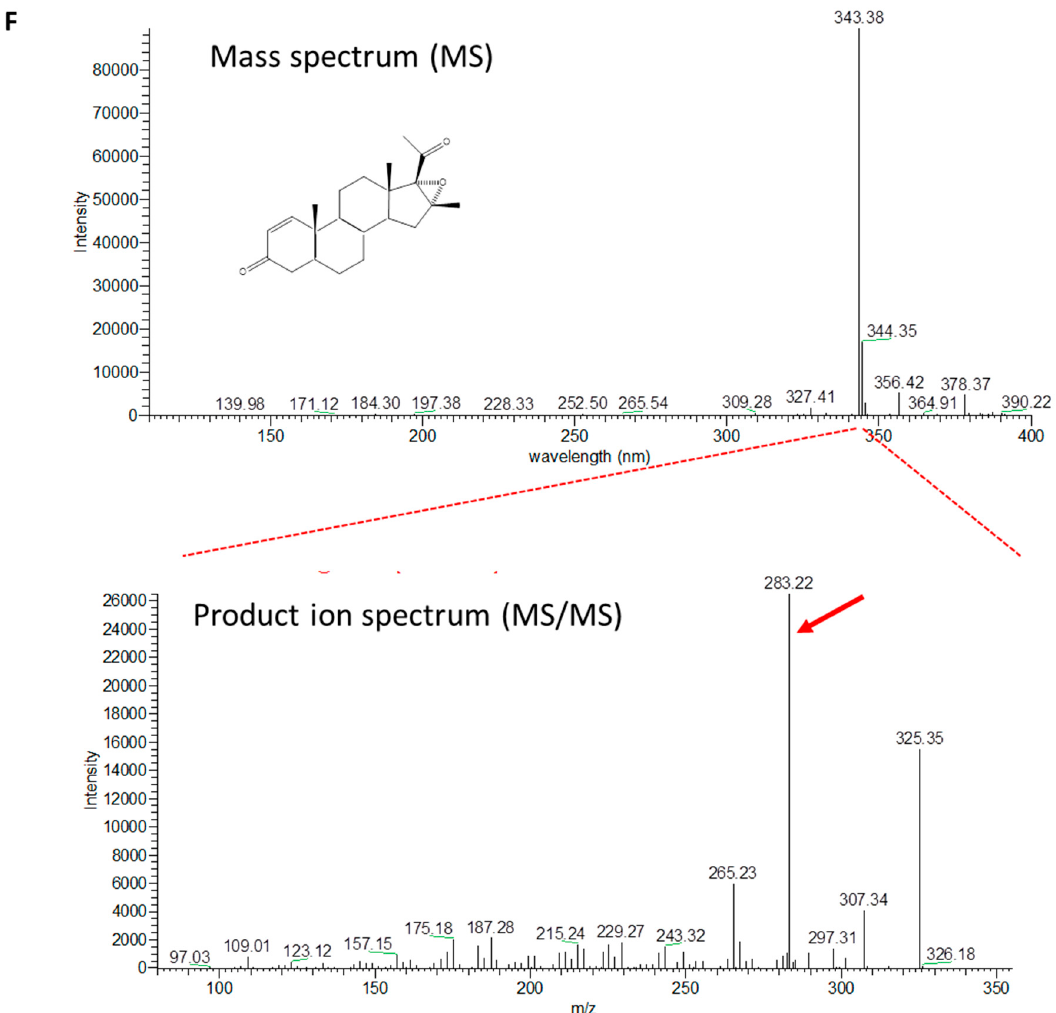
Figure 3. Production of epoxymethylprogesterone by C. glutamicum R31 (pCGL5228). Resting-cells assays of the control strain C. glutamicum R31 (pCGL0482) ( A ) or the producer strain C. glutamicum R31 (pCGL5228) ( B ). The data shown are representative of 3 independent experiments performed for 28 h with 2 mM epoxymethylpregnenolone at 30 ◦ C. The concentrations of epoxymethylpregnenolone and epoxymethylprogesterone are shown in green and red colours, respectively. Analysis by LC-MS of products of the reaction performed by C. glutamicum R31 (pCGL5228) at 0 h ( C ) and after 28 h of incubation ( D ). Chromatogram (SIM) of characteristic ions of epoxymethylpregnenolone ( m/z 327) (blue) and epoxymethylprogesterone ( m/z 343) (red). Chemical structure, average of mass spectra (upper), and average MS/MS spectra (product ion mass spectra) (lower) of epoxymethylpregnenolone ( E ) and epoxymethylprogesterone ( F ).